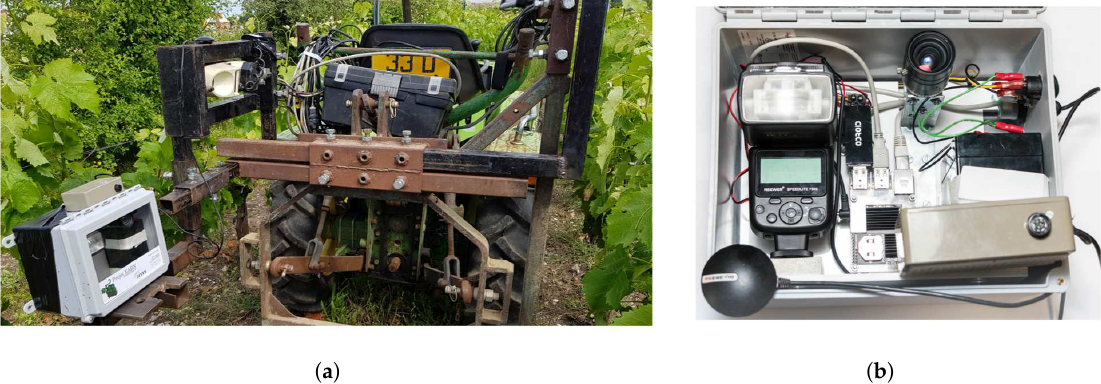
Figure 1. Instrumentation: an autonomous in-field imaging sensor, ( a ) a device embedded on a vine tractor and ( b ) details and elements of the device.